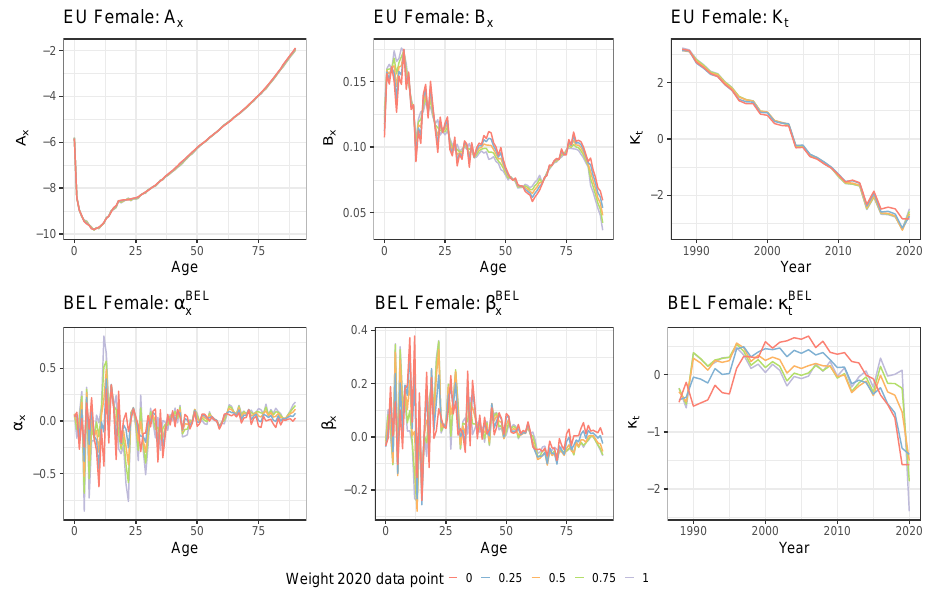
Figure 12. The European and Belgian parameters ˆ A x , ˆ B x , ˆ α x , ˆ β x , ˆ K t and ˆ κ t in the adjusted Lee and Miller mortality model for females. The coloured lines correspond to the different weighting scenarios in the calibration set-up. The mortality model is calibrated on data from 1988 to 2020 and contains virtually created deaths and exposures for the years